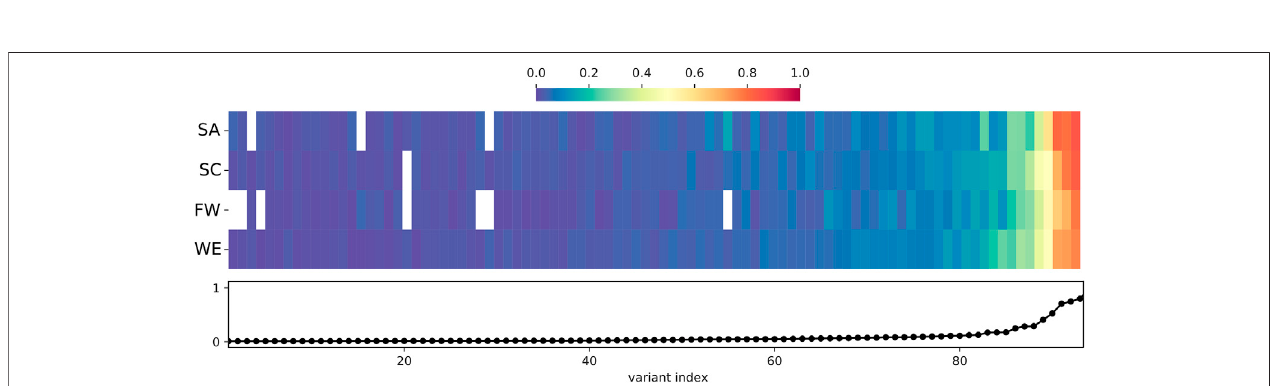
FIGURE 5 | Distribution and frequency of HI-vars across sub-populations. Only common HI-vars (Frequency > 1% in the total joint called population dataset) are representedinthe fi gure.Frequencyisthatofthenon-reference(ALT)allele.Thefrequencypervariantisreportedinthelowerpanelofthe fi gureasalineplot(indexedby frequency). The frequency of each of the variants in each sub-population is given by each heat map column, with white indicating 0% frequency. See Table 2 for